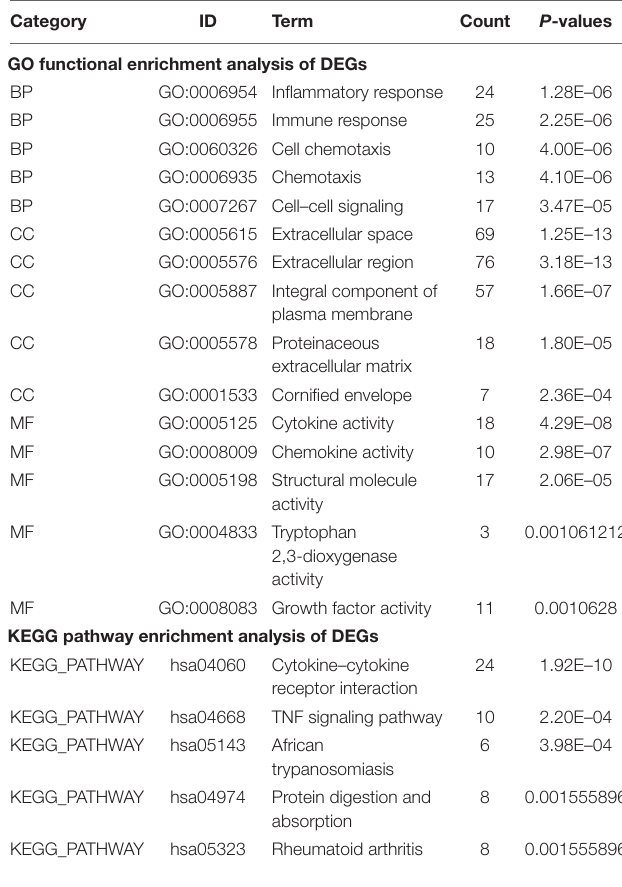
TABLE 2 | GO and KEGG enrichment analysis of